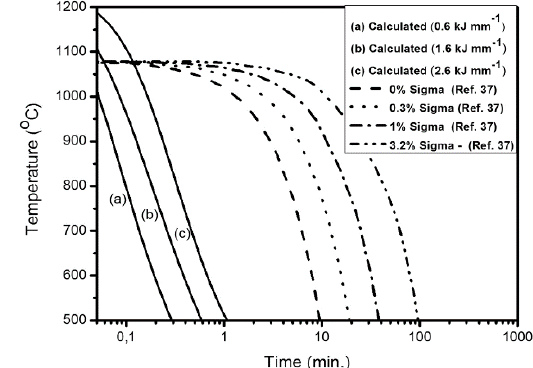
Figure 16. Comparison between calculated cooling curves and selected curves for sigma phase precipitation during continuous cooling of 2205 DSS.